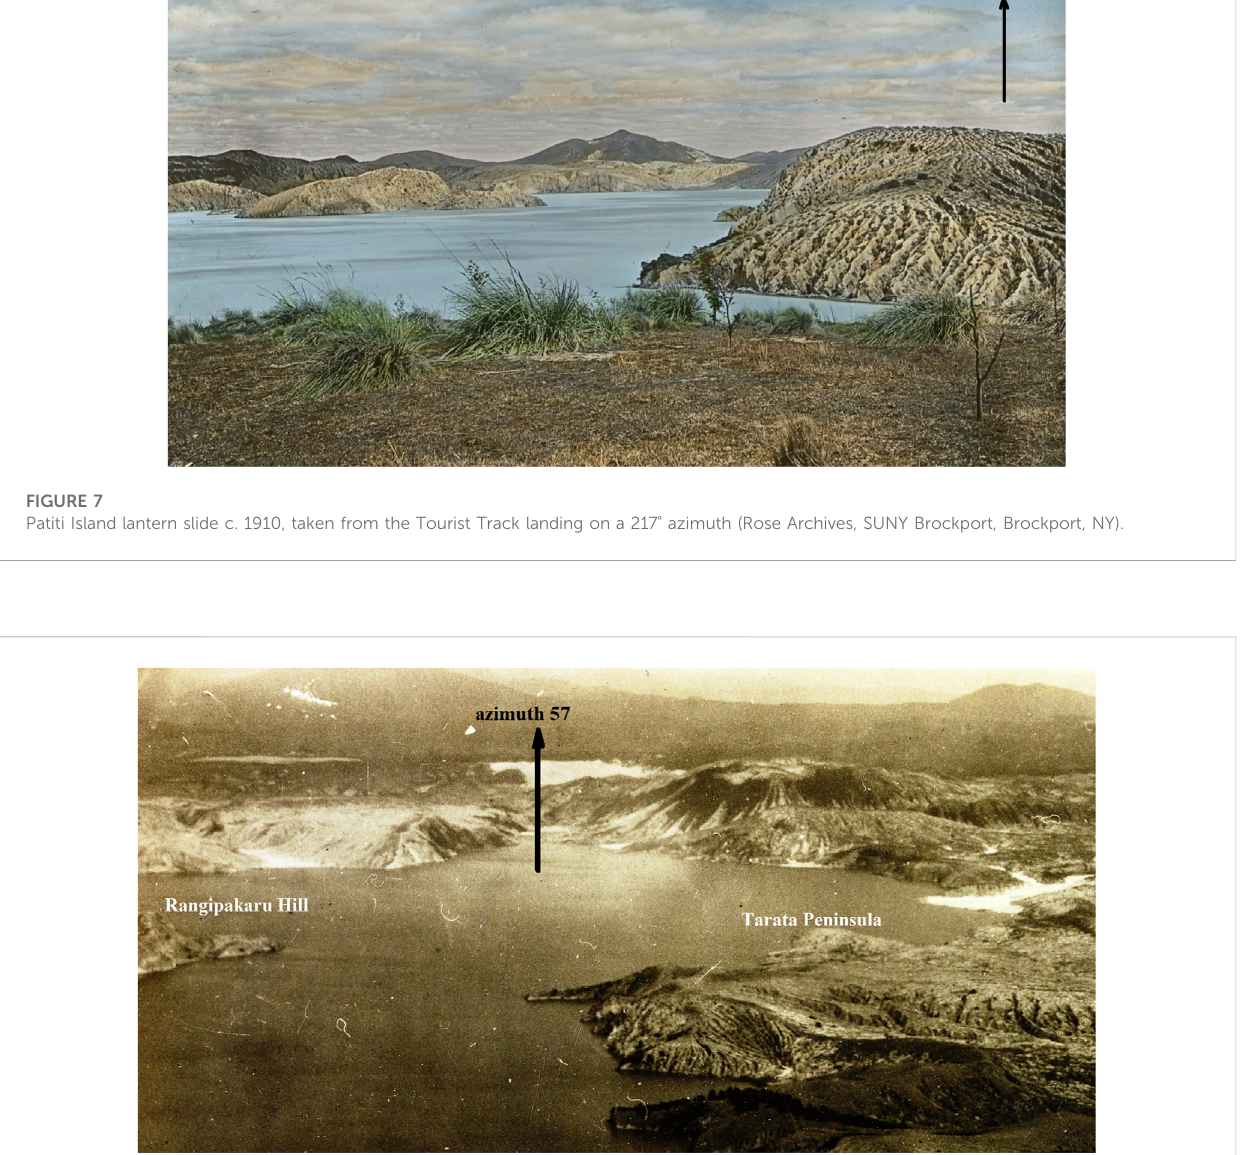
Puai Island is in the foreground. The eastern side of Te Rangipakaru survived the eruption. The lower ~35 m is today submerged, with Patiti Island being the upper 66 m. In Figure 7, the posterior eastern side is shown in a 1910 lantern slide, taken along azimuth 217 ° . The island was unvegetated in 1910.